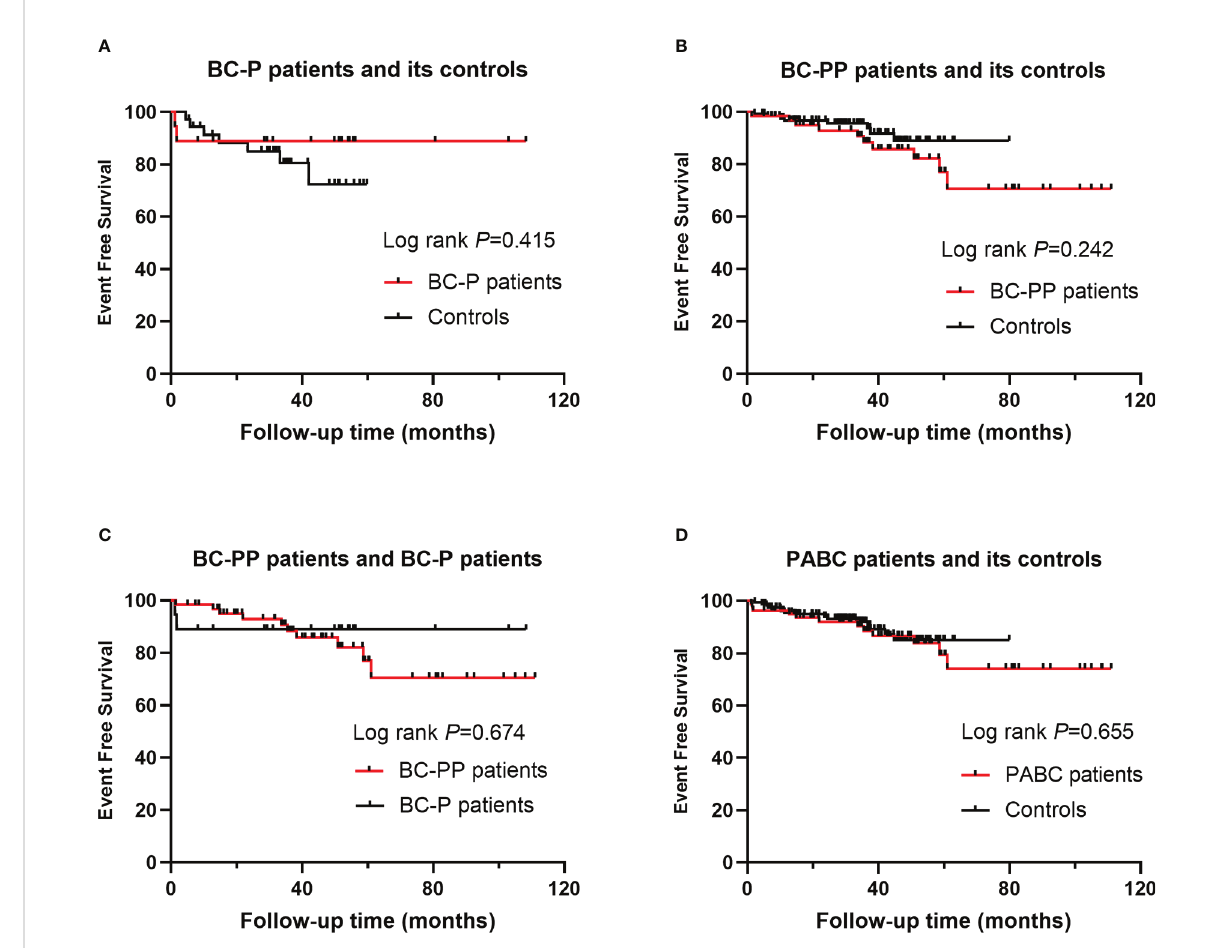
FIGURE 2 Event free survival (EFS) for PABC patients and their controls: (A) EFS for BC-P patients and its controls; (B) EFS for BC-PP patients and its controls; (C) EFS for BC-P patients and BC-PP patients; (D) EFS for PABC patients and its